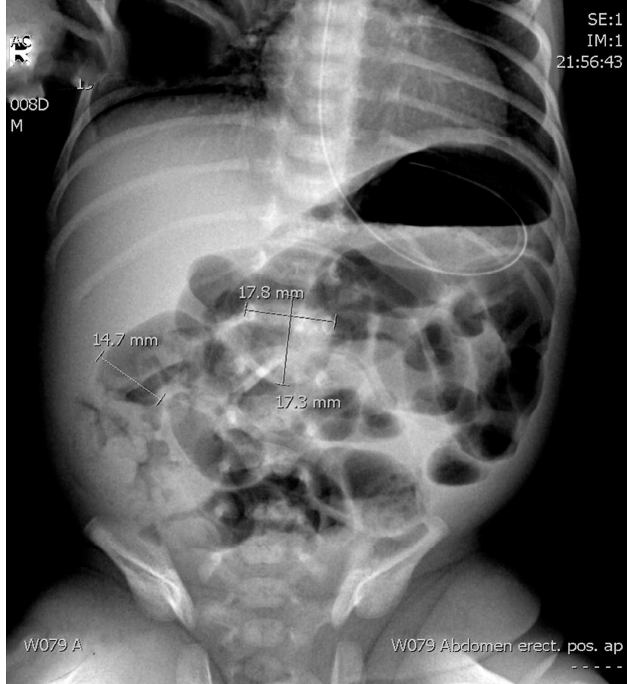
Figure 2. Supine anteroposterior projection abdominal radiography of a preterm infant with necrotizing enterocolitis with the measurement mode shown.